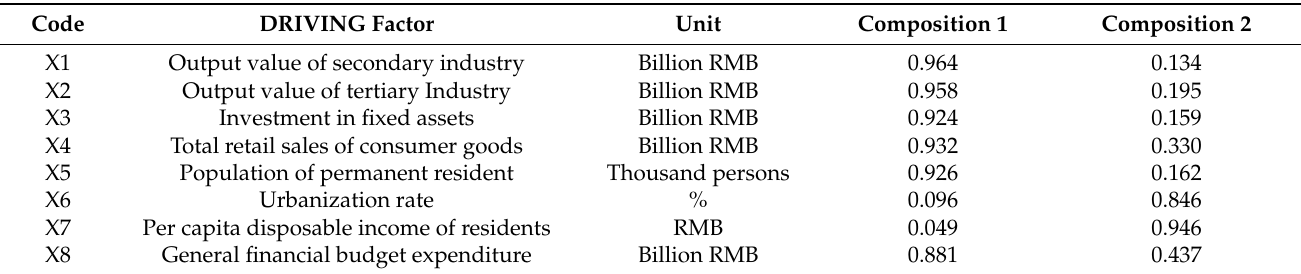
Table 4. Component matrix (after